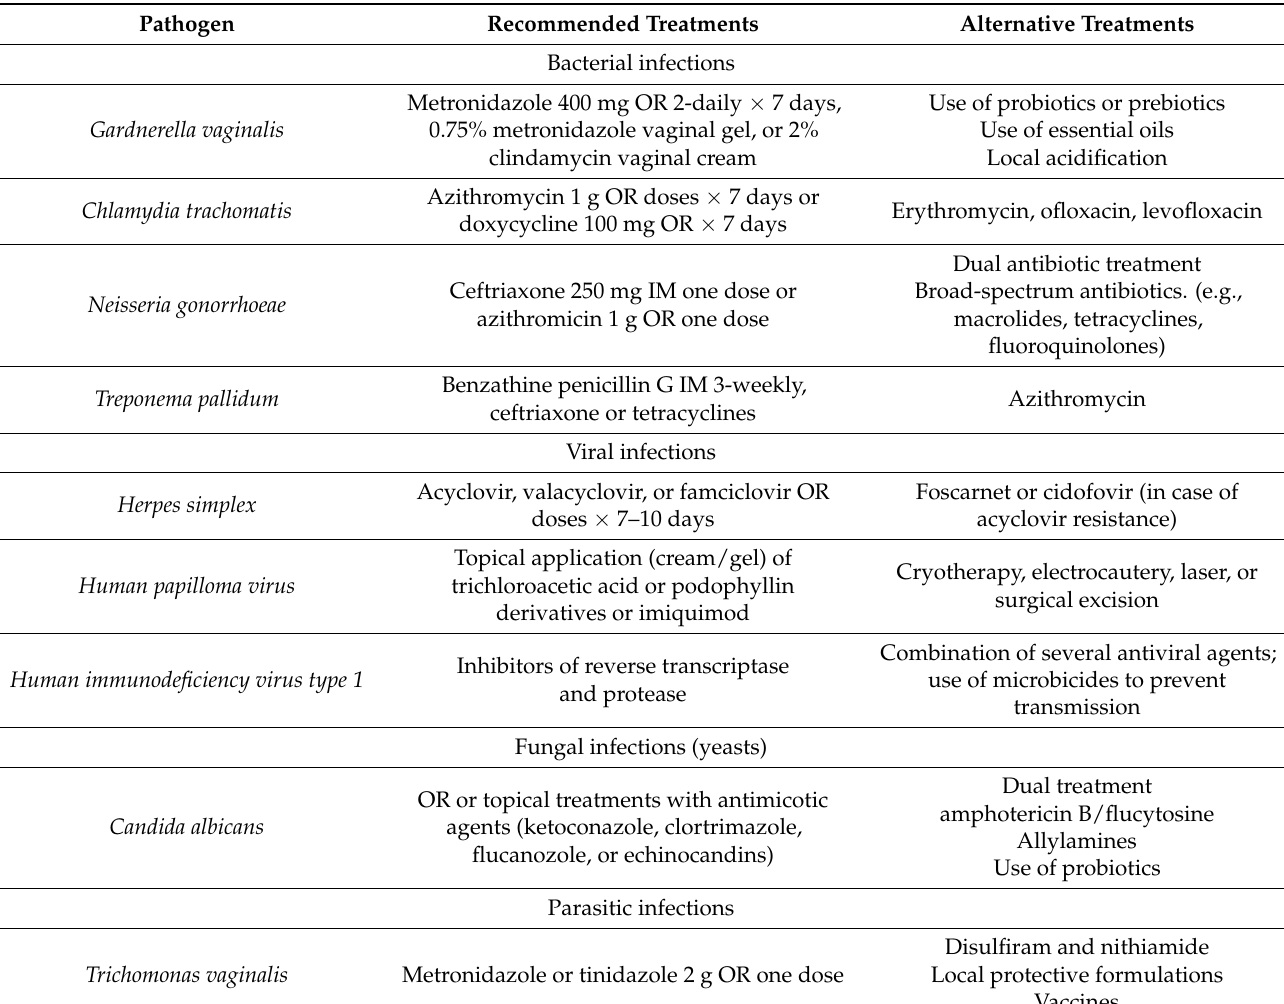
Table 1. Pathogens and treatments of vaginal